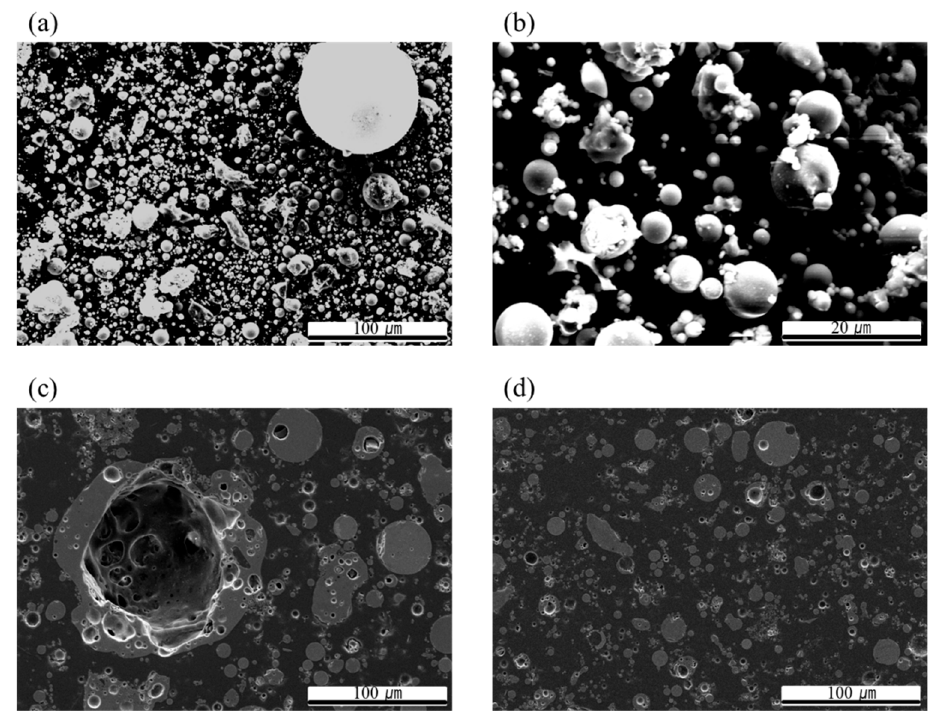
Figure 1. General microstructure under SEM for ( a ) Fly ash powder, low magnification, ( b ) Fly ash powder, high magnification, ( c ) Cross section of larger fly ash, ( d ) Cross section of smaller fly ash.